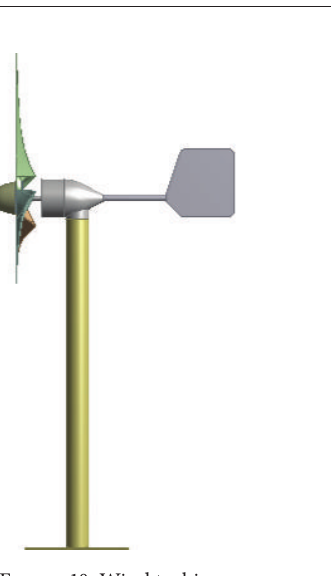
Figure 10: Wind turbine.